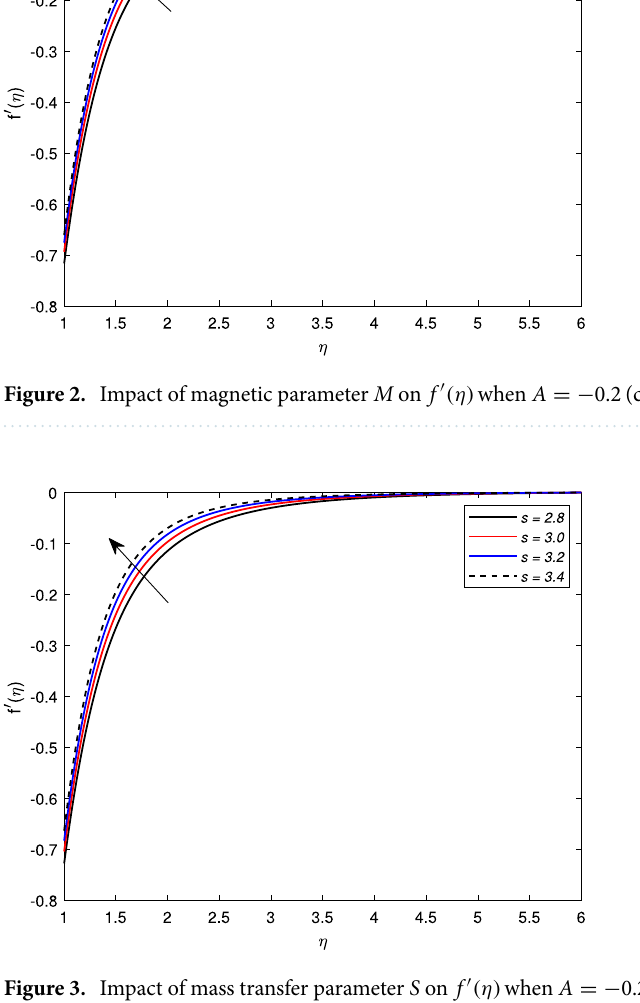
Figure 3. Impact of mass transfer parameter S on f ′ (η) when A